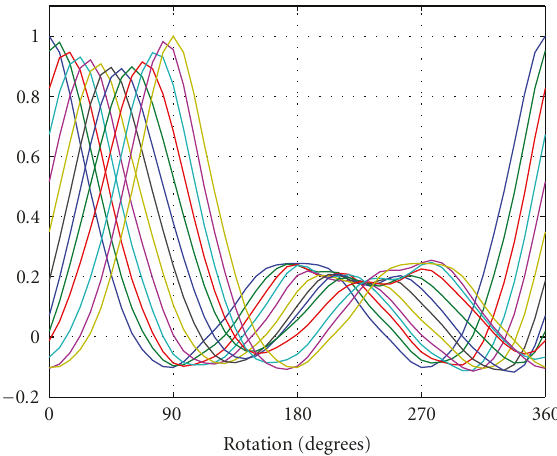
Figure 2: Correlation results for the template shown in Figure 3: each curve represents the Polar Matching output obtained by correlating the template with rotated versions of itself, in 5 ◦ increments from 0 ◦ to 90 ◦ . For each curve, the output is a response with respect to 48 angles in 7 . 5 ◦ increments.